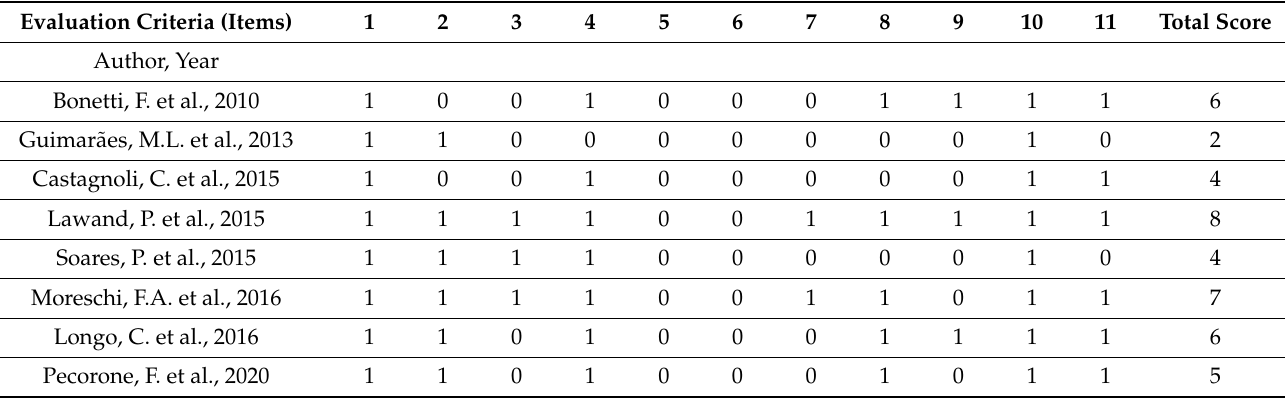
Table 3. Evaluation of the quality of the studies according to the PEDro